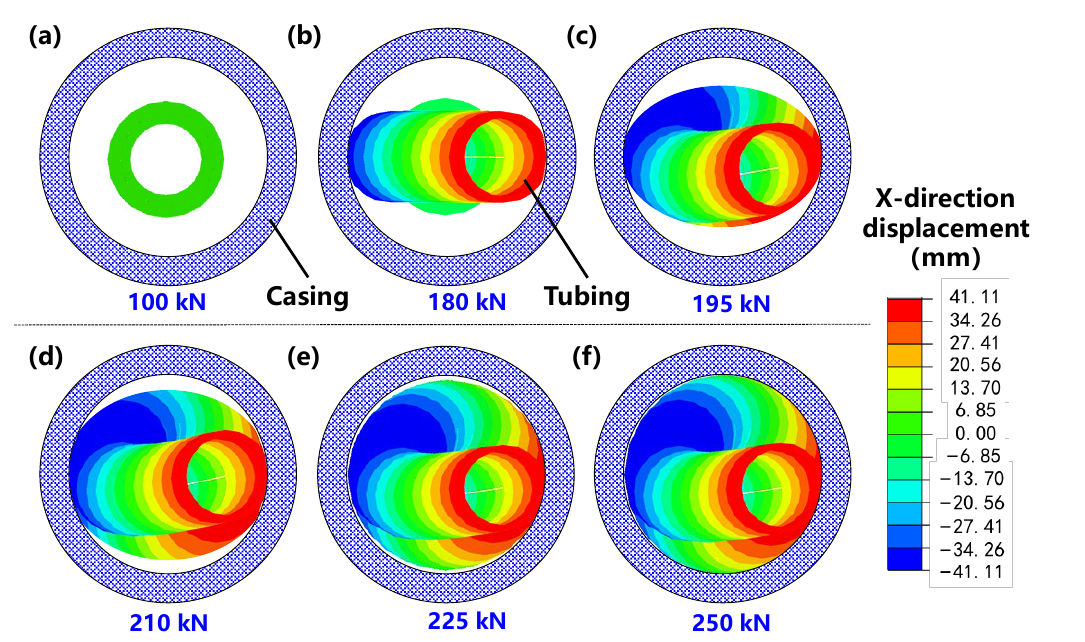
Figure 16. Contact between tubing and casing under six working conditions from the perspective of the well bottom: ( a ) Ⅰ condition, ( b ) Ⅱ condition, ( c ) Ⅲ condition, ( d ) Ⅳ condition, ( e ) Ⅴ condition, and ( f ) Ⅵ condition.